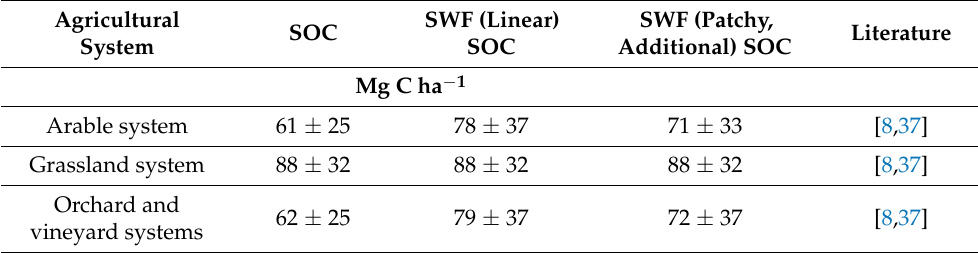
Table A1. Soil organic carbon (SOC) in the upper (0–30 cm) soil layer in agricultural systems and SWFs.